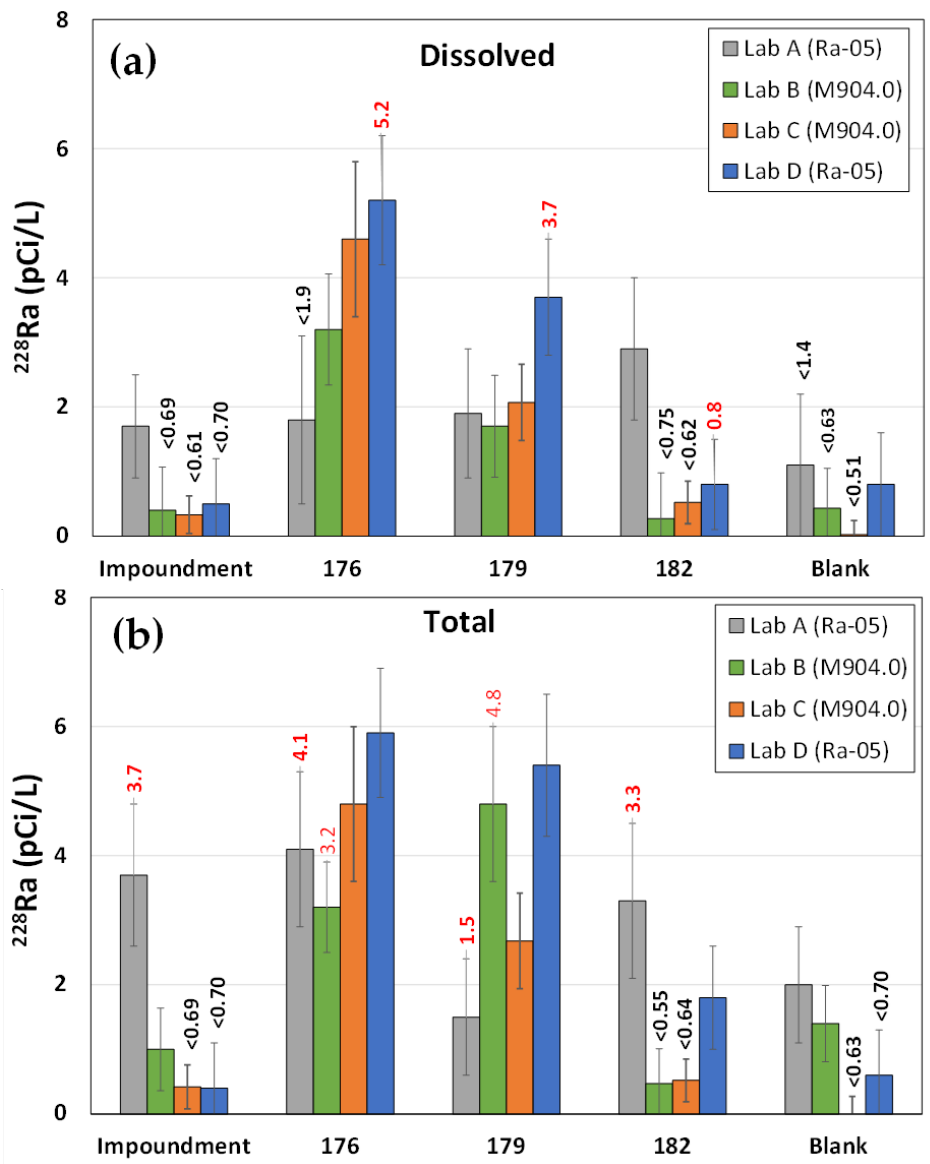
Figure 4. Comparison of ( a ) Dissolved 228 Ra; ( b ) Total 228 Ra. Values in red are qualified as estimated with high bias (J+) when sample result contained <10× the amount measured in the field blank. Values in black signify the MDC when the reported value is less than the MDC.